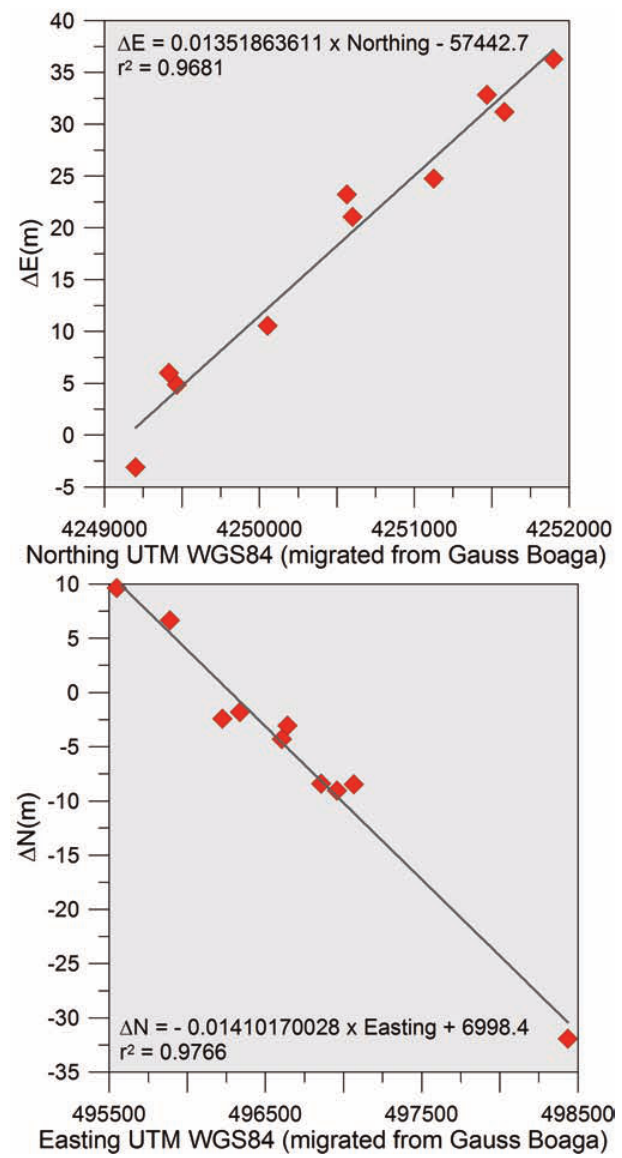
Figure 6. Best fits via linear regression of Easting residuals versus Northing (top), and Northing residuals versus Easting